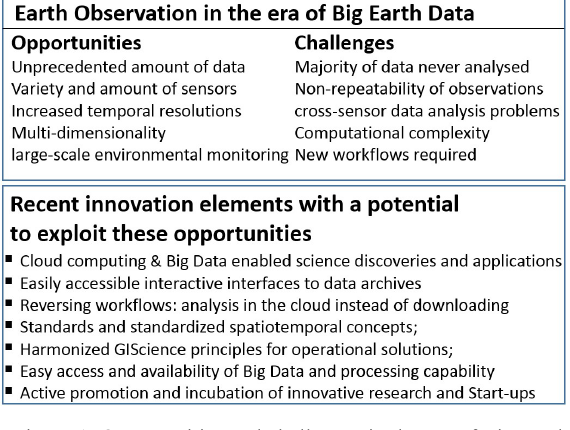
Figure 1. Opportunities and challenges in the era of Big Earth Data and some recent innovation